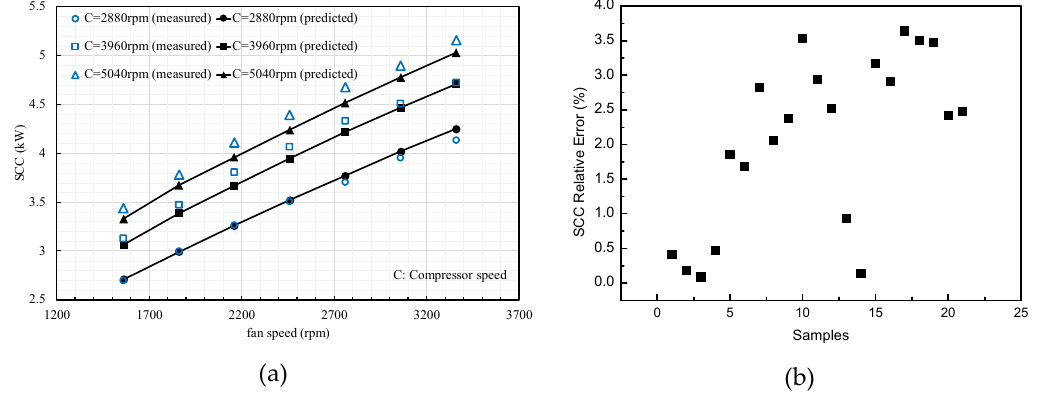
Figure 5. Comparison results for the measured and predicted values of SCC, ( a ) SCC; ( b ) Relative error.